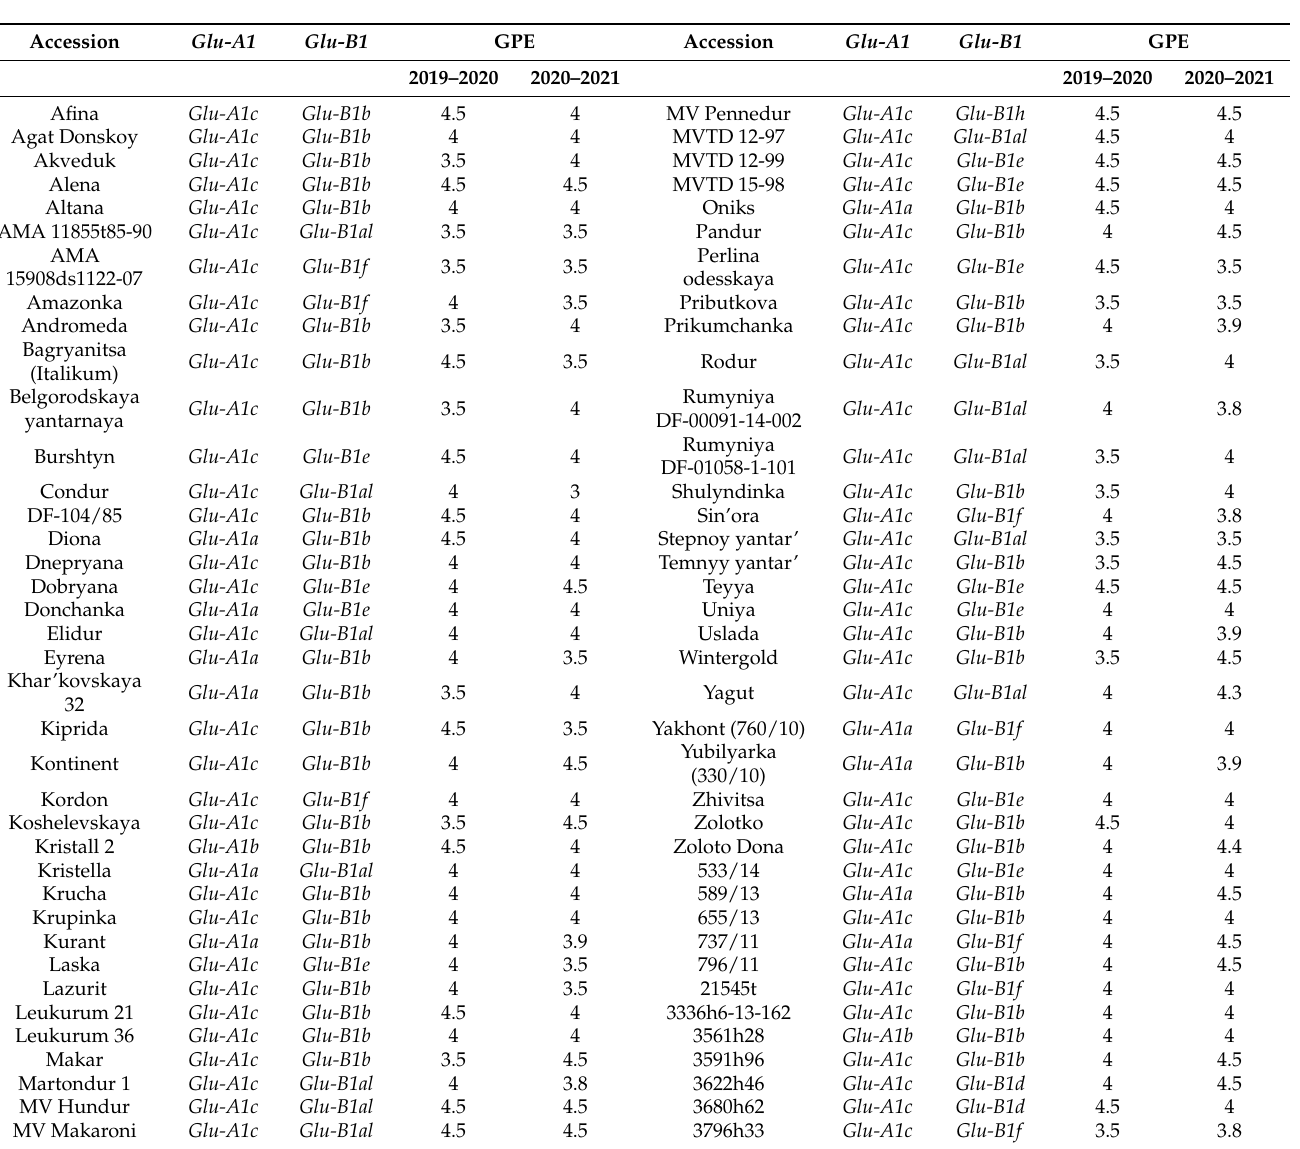
Table 1. Allelic state of Glu-A1 and Glu-B1 in the studied collection of durum wheat and their values of general pasta estimation